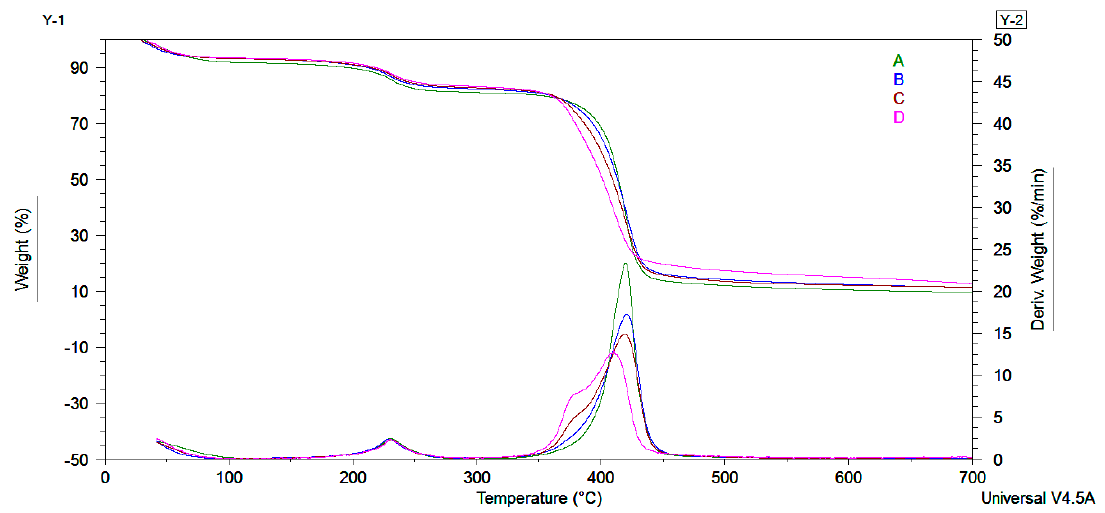
Figure 5. TGA/DTG curves for the obtained hydrogel nanocomposites (B-PMAA-Cl 93A, C-PMAA-Cl 93A-C8, D-PMAA-Cl 93A-C18) against polymer matrix Table 2. TGA/DTG and DMA results for the obtained hydrogel samples.